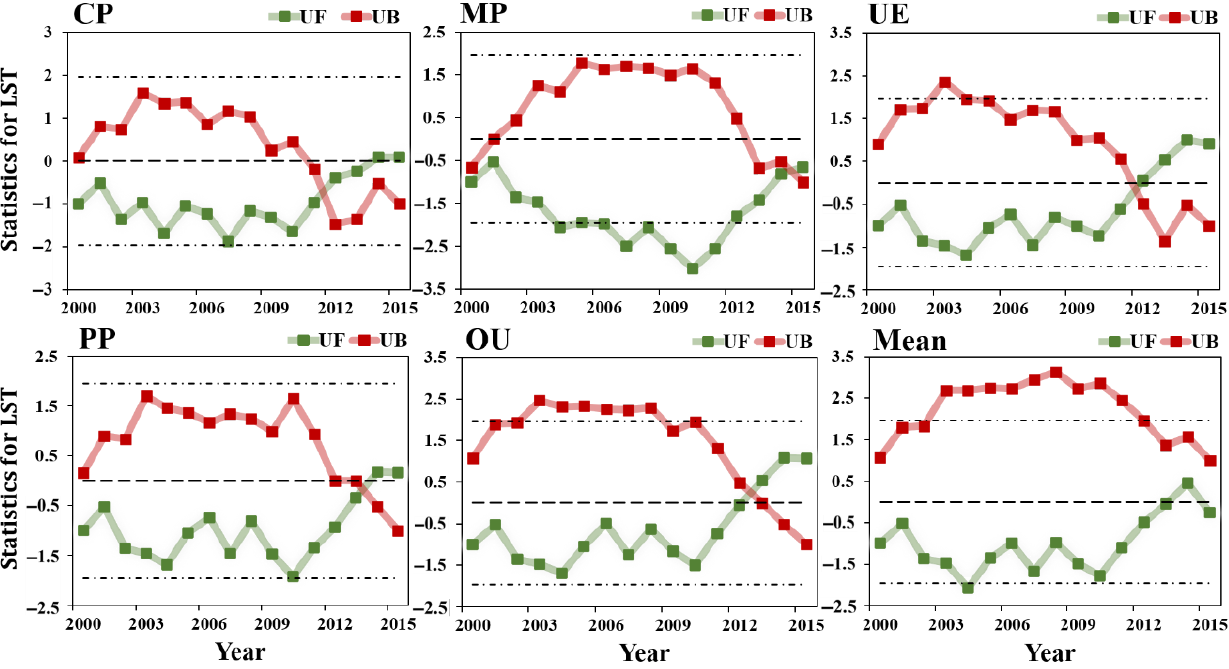
Figure 17. Mann – Kendall test of land surface temperature (LST) of different land use types in the Huang-Huai-Hai River Basin from 2000 to 2015.